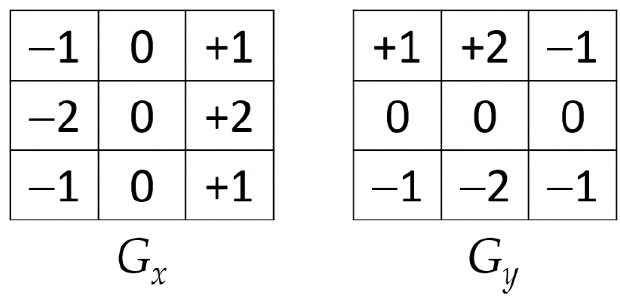
Figure A7. A 3 × 3 masks of a Canny ED technique.